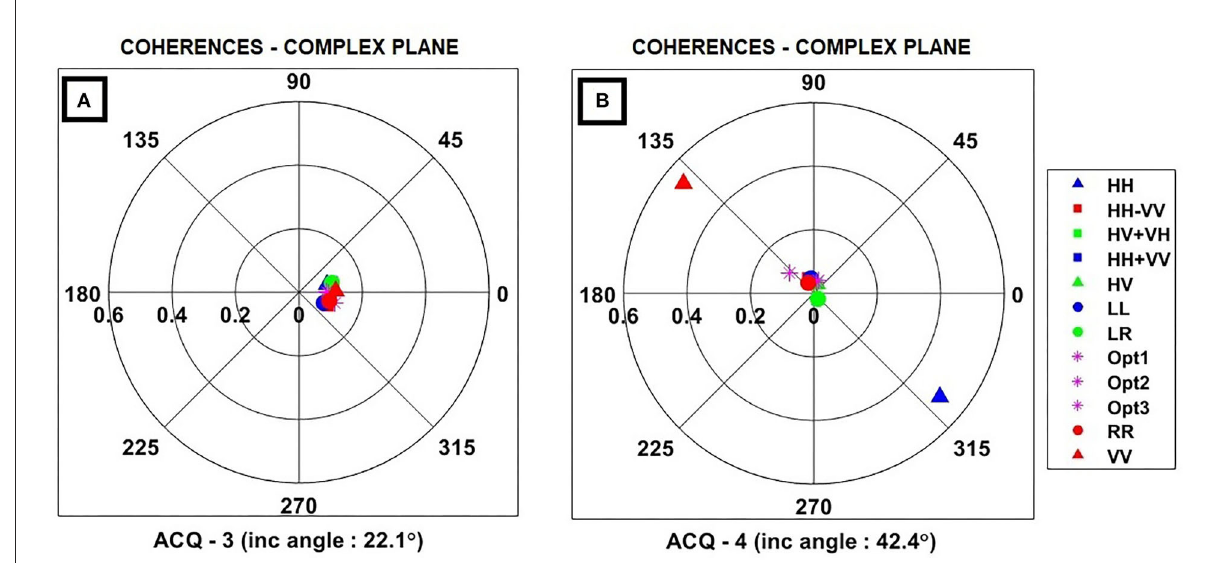
FIGURE7 Complex coherences plotted for linear, Pauli, circular, and optimal basis. Color code opted: Blue - HH, HH - VV, HH-VV, RR; Magenta - optimal basis. (A) Complex plane signature of ACQ-3 having steep angle of incidence. (B) Complex plane signature of ACQ-4 having shallow angle of